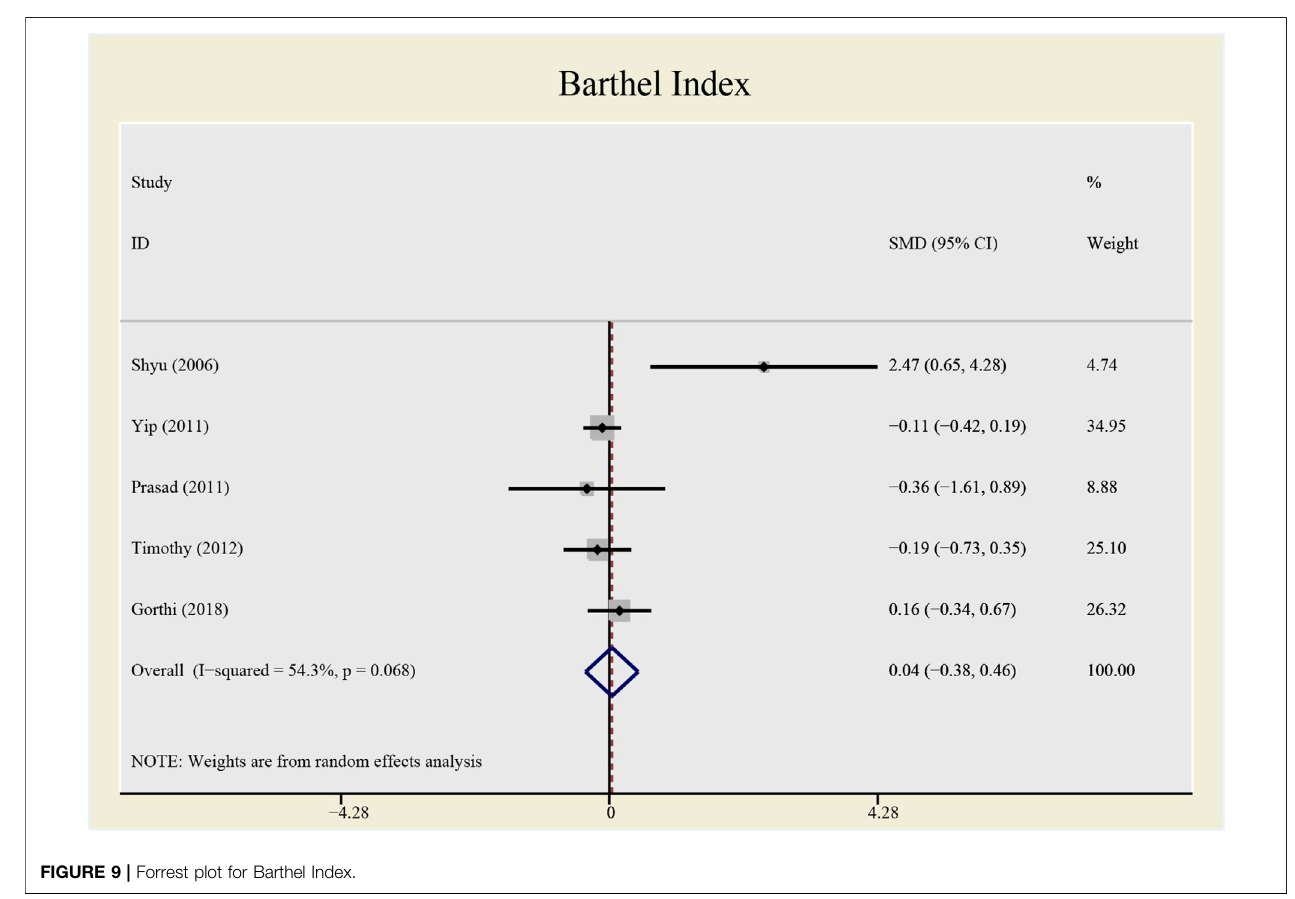
FIGURE 9 | Forrest plot for Barthel Index.